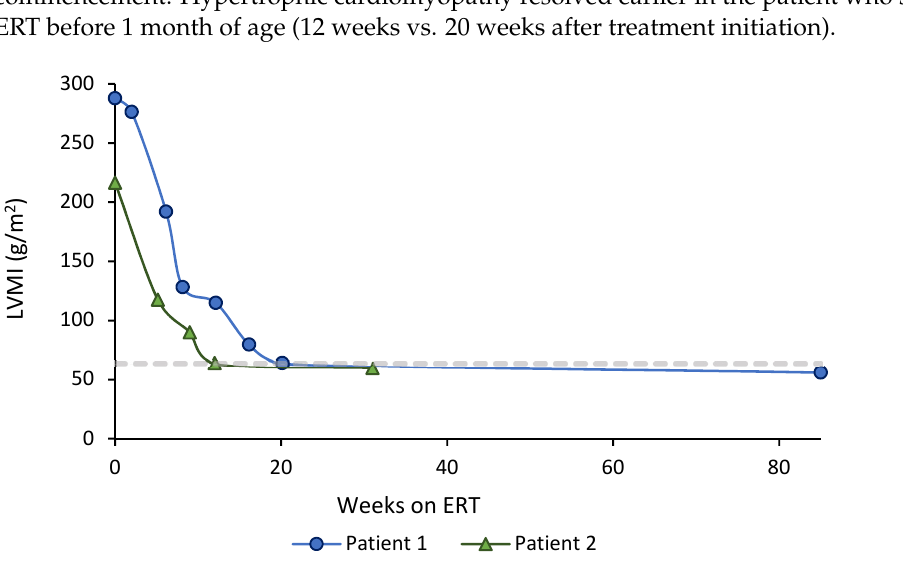
Figure 2. Left ventricular mass index (LVMI) evolution after ERT initiation in Patient 1 (started ERT < 3 months of age) (blue line), and Patient 2 (started ERT < 1 month of age) (green line). The horizontal dashed line indicates the upper limit of normal for LVMI (g/m 2 ) in healthy infants (64 g/m 2 )